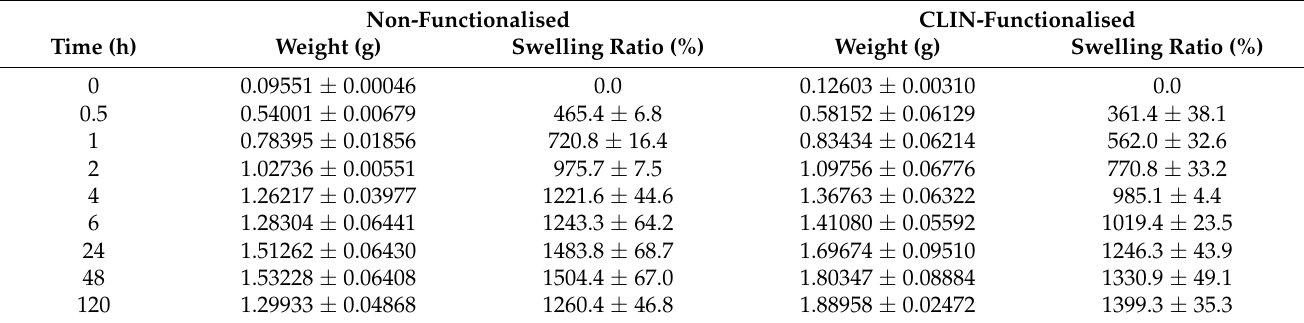
Table 3. The results obtained in the experiments to determine the degree of swelling. The results are given as average values ± standard deviation for the replicate